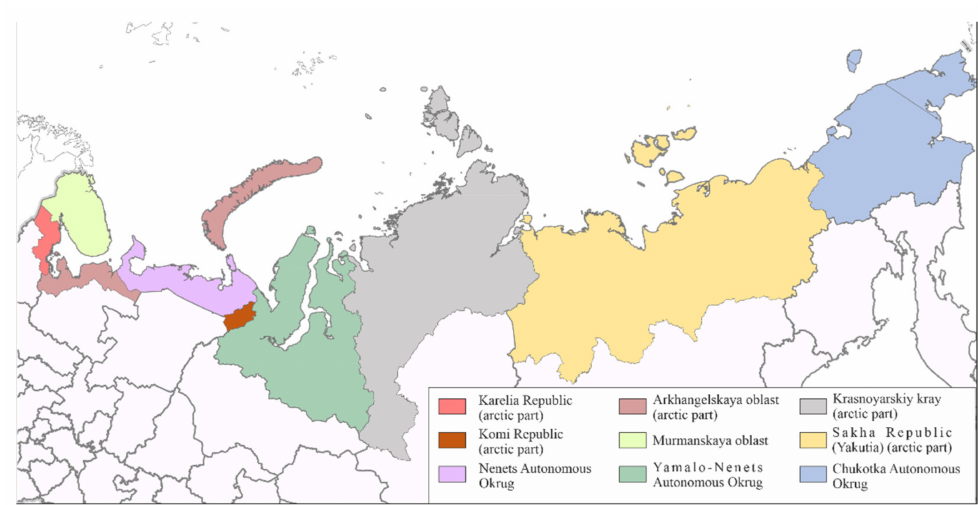
Figure 1. The locations of the AZRF regions. Source: compiled by the